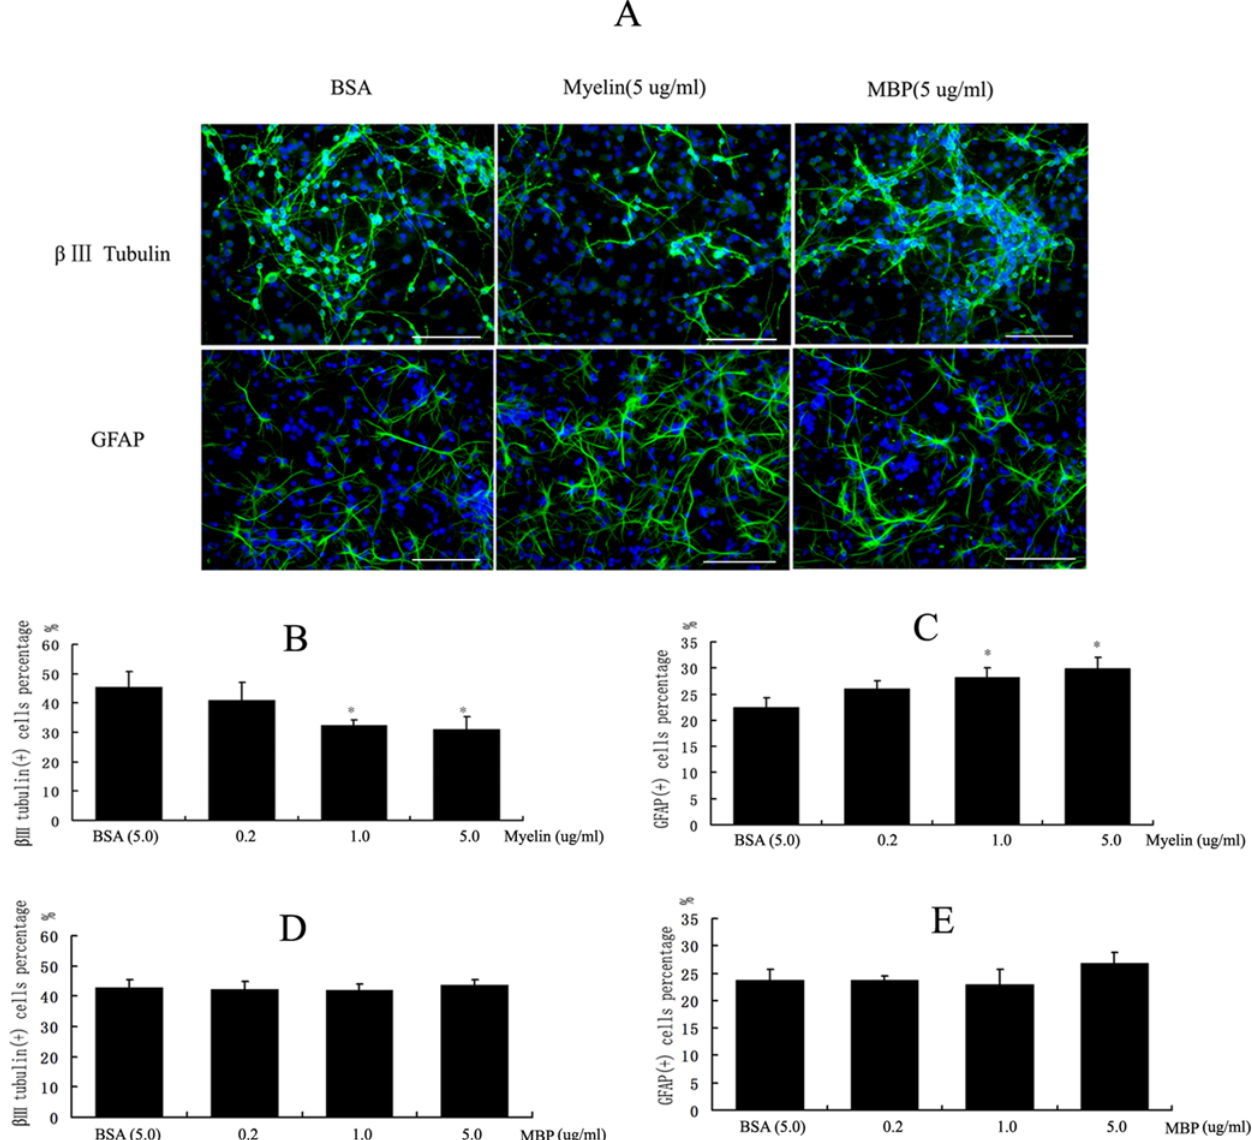
Figure 2. The differentiation of NPCs treated by Myelin and MBP, respectively. (A) The immunostaining images of NPCs treated by myelin and MBP. (B) The result of a b III tubulin antibody immunostaining in NPCs exposure to myelin preparation for 8 days. The proportion of positive cells was 32.35 6 1.91% and 30.95 6 4.32% in 1.0 ug/ml and 5.0 ug/ml soluble myelin treatment respectively, significantly lower than 45.38 6 5.31% in 5.0 ug/ml BSA control ( p , 0.05). (C) The result of GFAP antibody immunostaining in NPCs exposure to myelin preparation for 8 days. The proportion of GFAP positive cells was 28.19 6 1.1.78% and 29.83 6 2.16% in 1.0 ug/ml and 5.0 ug/ml soluble myelin treatment respectively, significantly higher than 22.53 6 1.85% in 5.0 ug/ml BSA control ( p , 0.01). (D, E) Purified MBP did not affect the neural differentiation of NPCs.